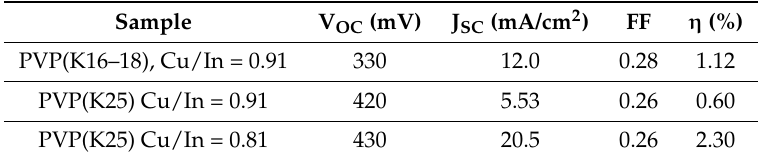
Table 2. PV parameters evaluated from the J-V curves for the CIS solar cells.